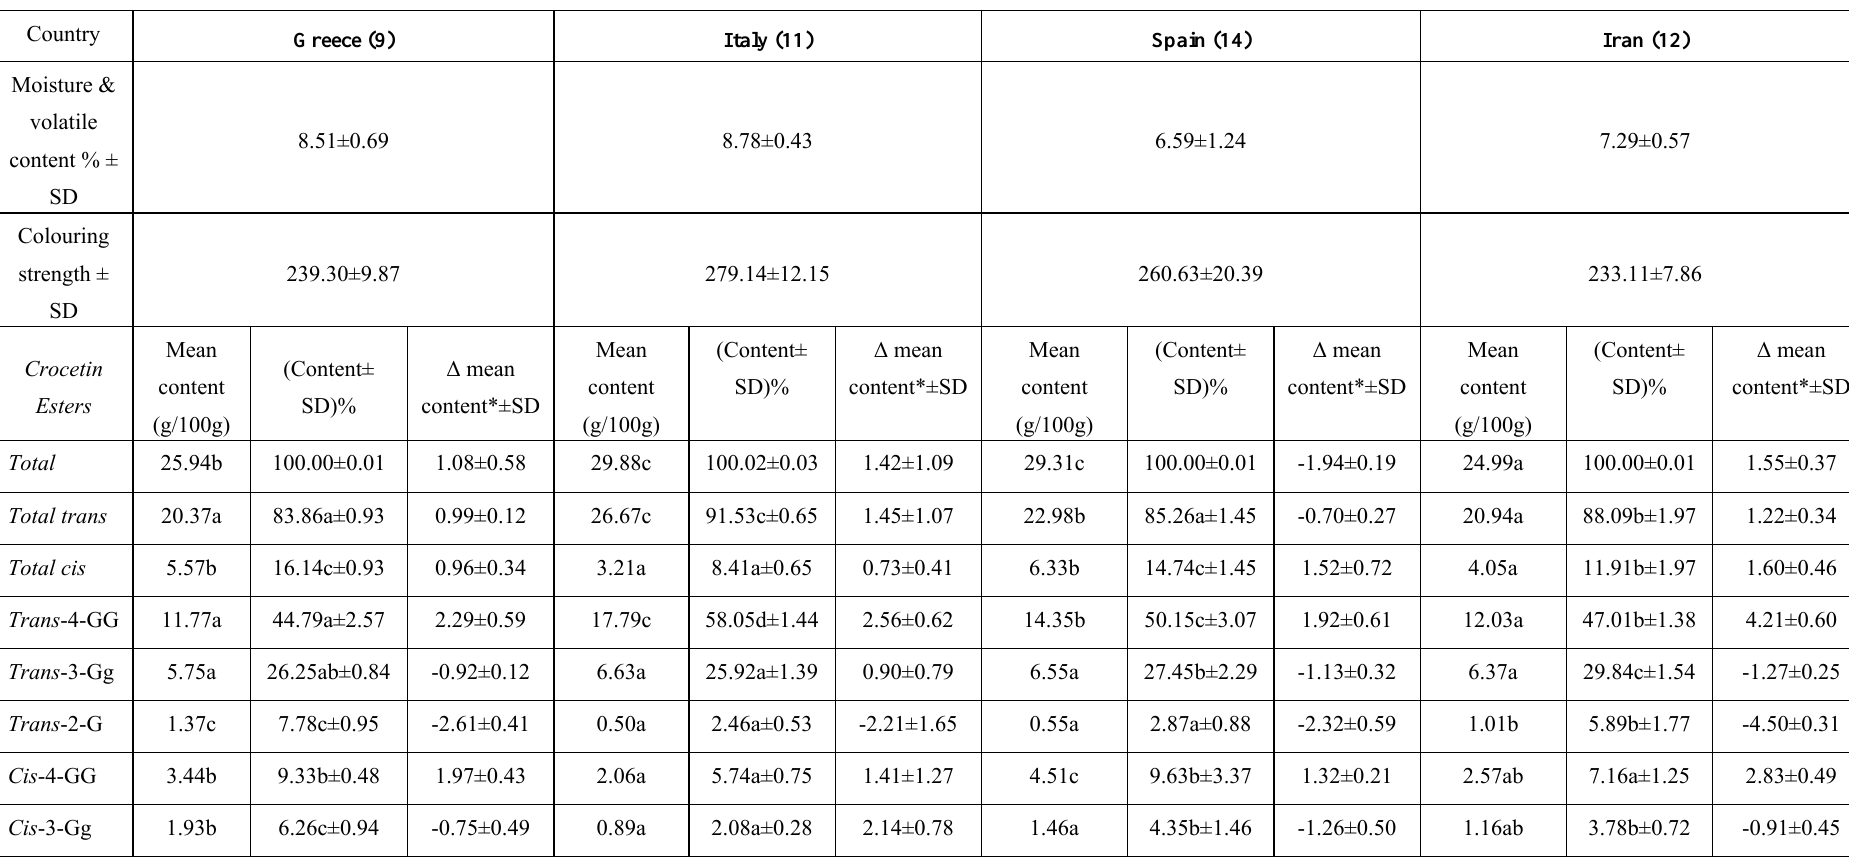
Table 3 . Quality characteristics and content of each crocetin ester in saffron aqueous extracts coming from Greece, Italy, Spain and Iran, stabilized by means of propylparaben addition (200